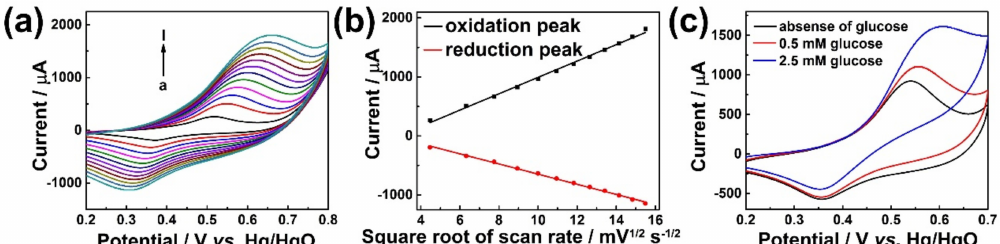
Figure 4. ( a ) Cyclic voltammograms of the Ni 0.7 Co 0.3 (OH) 2 / carbon paper (CP) electrode scanned from + 0.2 to + 0.8 V vs. Hg / HgO in 0.1 M NaOH at variable scan rates. ( b ) The corresponding Randles–Sevick plot to ( a ). ( c ) The CV curve of the Ni 0.7 Co 0.3 (OH) 2 drop-casted carbon paper electrode in absence and presence of 0.5 and 2.5 mM glucose.